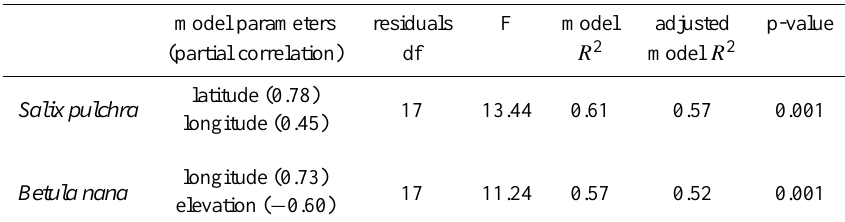
Table 4. Statistics of multiple regression models explaining the similarities of the shrub chronologies from this study to the regional Larix spp. tree ring-width chronologies shown in Table